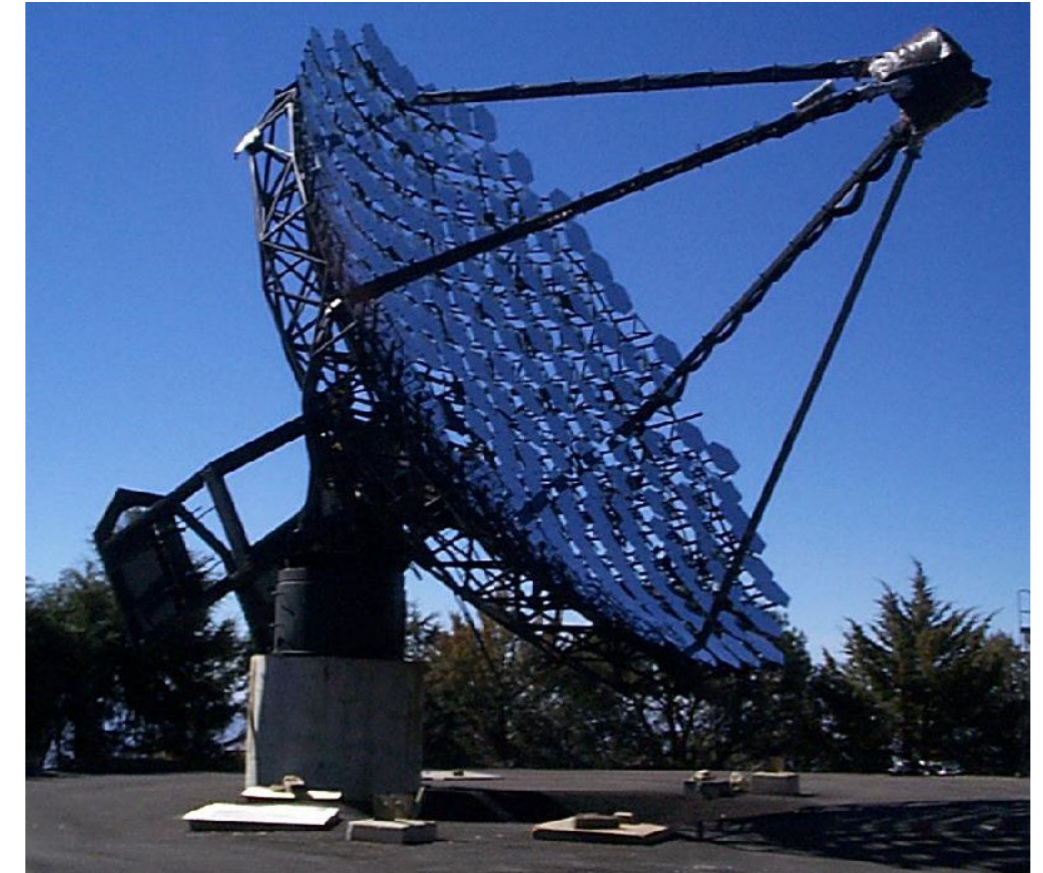
Figure 4. Photo of the 10 m diameter pioneering Whipple IACT on Mount Hopkins in Arizona.